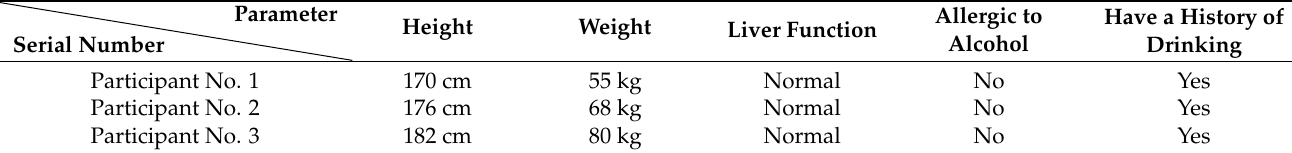
Table 3. Physical conditions of the test